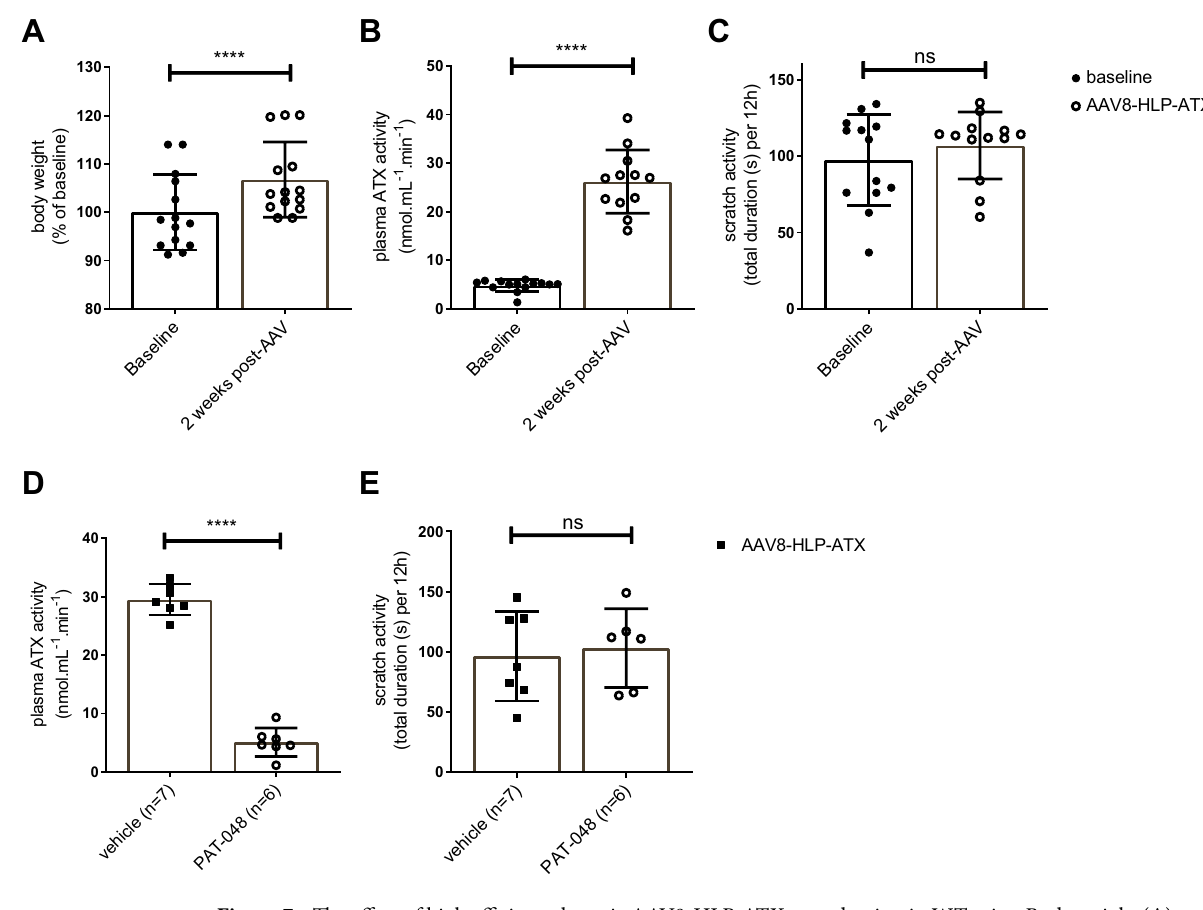
Figure 7. The effect of high efficiency hepatic AAV8-HLP-ATX transduction in WT mice. Body weight ( A ) and plasma ATX activity ( B ) were measured at baseline and 2 weeks after AAV-HLP-ATX injection in WT mice (n = 13). Scratch activity ( C ) was measured during four consecutive nights at baseline and 2 weeks after AAV- HLP-ATX injection in WT mice (n = 13). Plasma ATX activity ( D ) was measured 28 days after AAV and 24 h after the 4th dose of the ATX-inhibitor PAT-048 (oral gavage 20 mg/kg/day, n = 6) and vehicle (n = 7). Scratch activity ( E ) was measured as the mean of day 24–27 post-AAV injection, during oral gavage of PAT-048 (20 mg/ kg/day, n = 6) and vehicle (n = 7). Bars depict mean ± SD. Statistics: paired t-test within groups ( A,B,C ), unpaired t-test between groups ( D,E ), ns: not significant, ****indicates p -value <